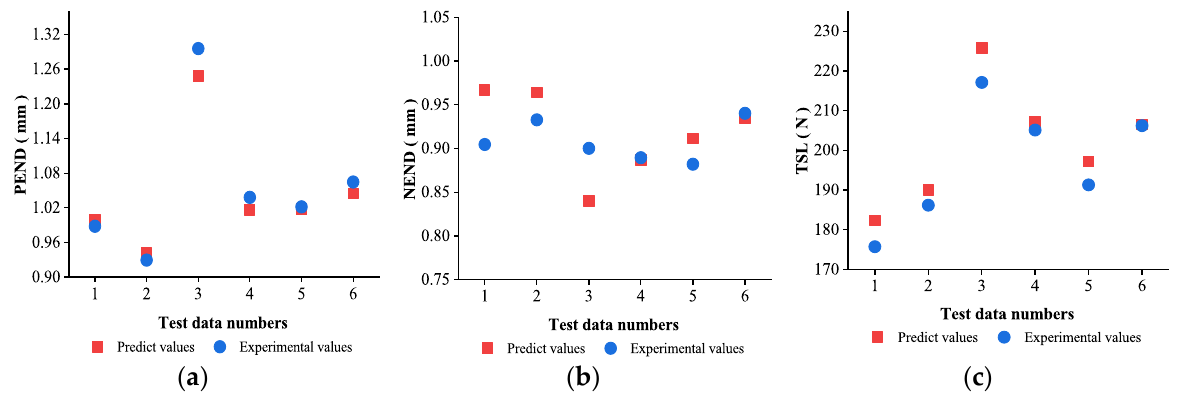
Figure 7. Comparison of predicted values and experimental values. ( a ) PEND of comparison chart; ( b ) NEND of comparison chart; ( c ) TSL of comparison chart.